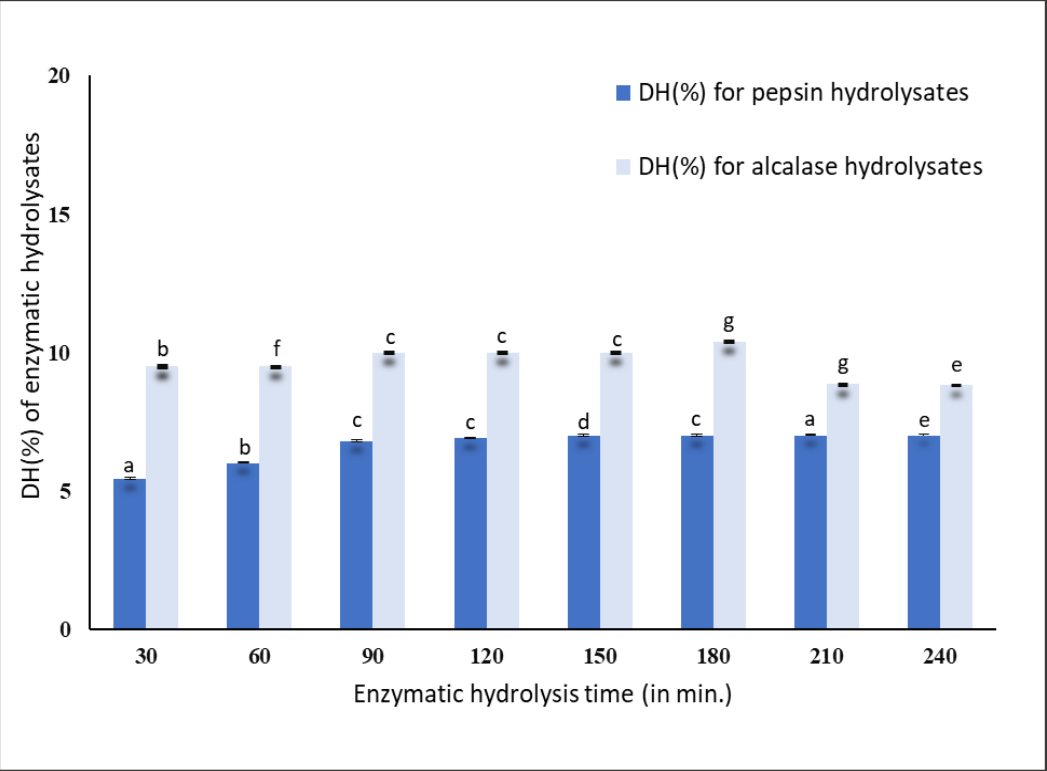
Figure 1. Determination of the degree of hydrolysis (DH (%)) of enzymatic hydrolysates using the OPA (O-phthalaldehyde) method. Values and error bars indicate the means and standard deviations, respectively, of triplicate analyses for each of the pepsin and alcalase hydrolysates. Values with different superscripts (a, b, c, …) indicate significant differences between the sample means at p < 0.05